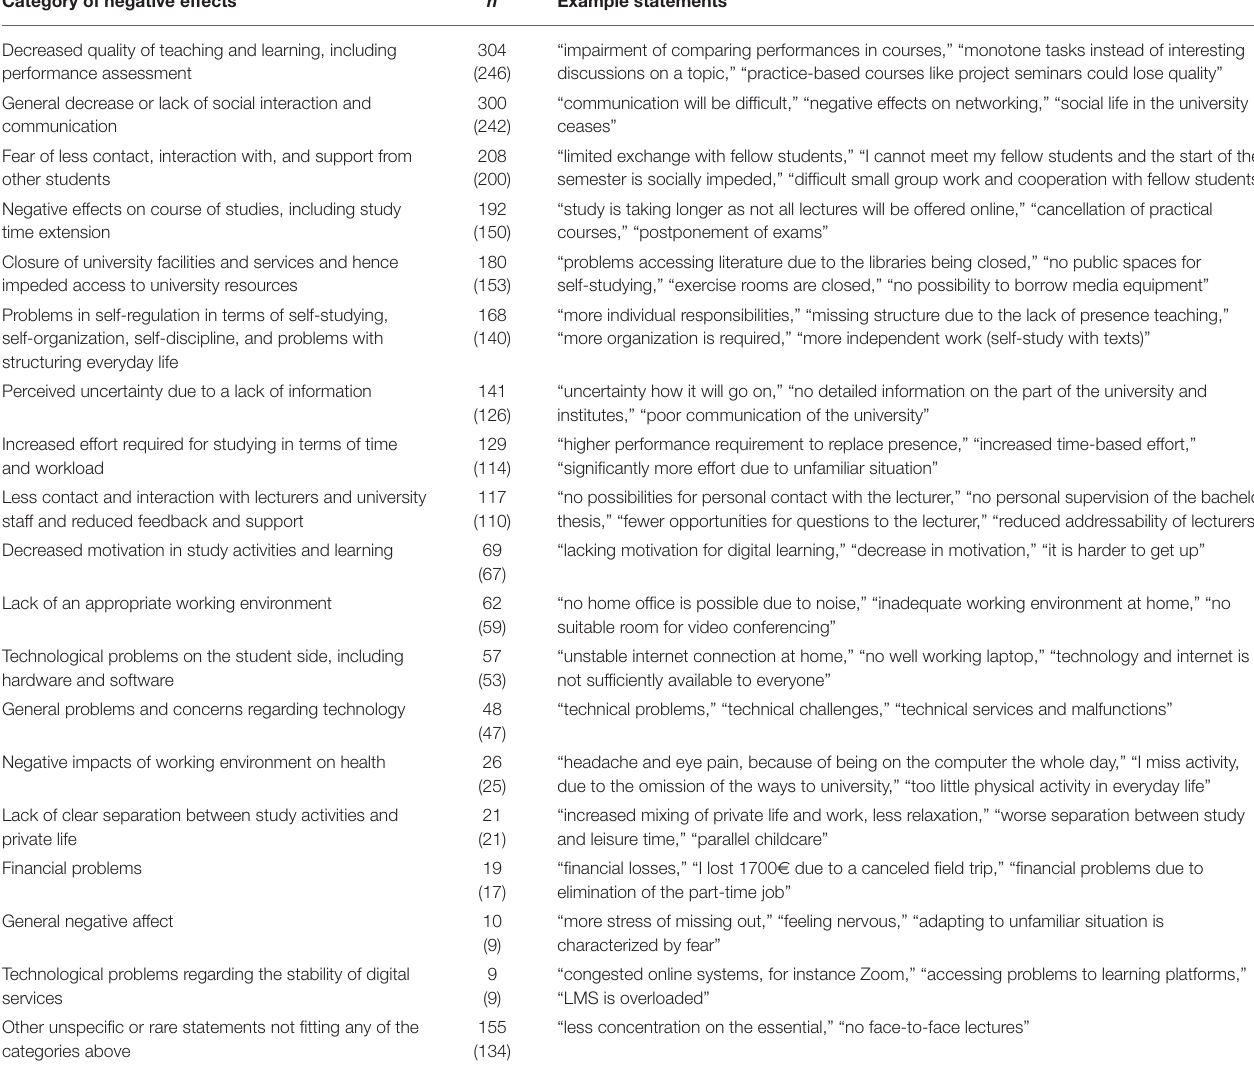
TABLE 1 | Category descriptions, number of statements in descending order, and example statements for negative